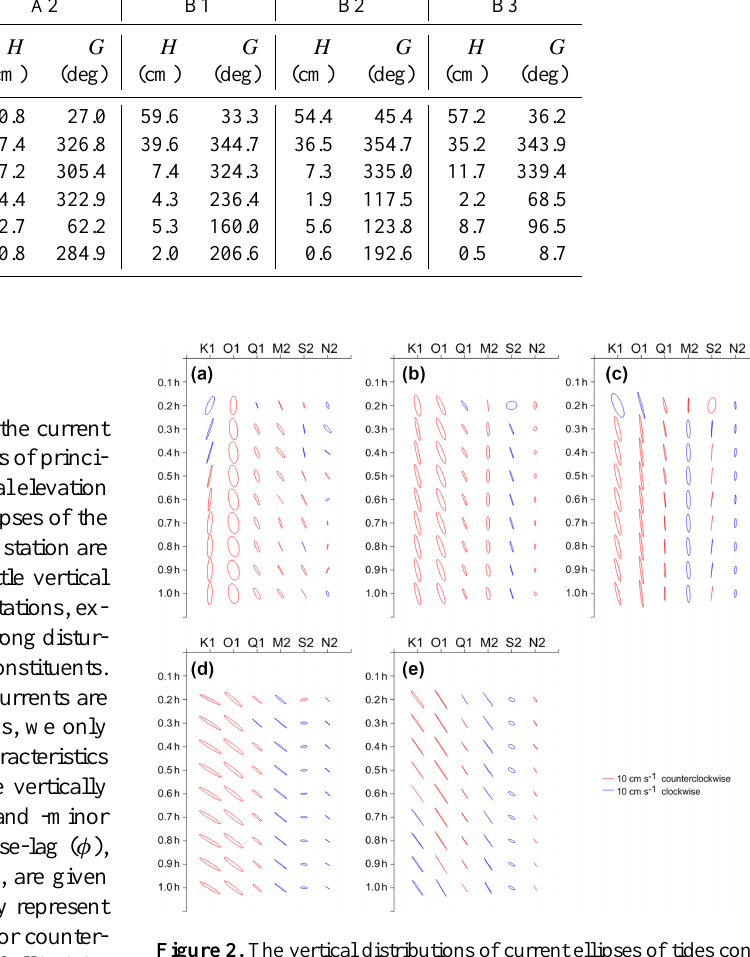
Figure 2. The vertical distributions of current ellipses of tides con- stituents K 1 , O 1 , Q 1 , M 2 , S 2 , and N 2 at Stations A1 (a) , A2 (b) , B1 (c) , B2 (d) , and B3 (e) . rent ellipses of the semidiurnal constituents M 2 and S 2 are generally smaller than 5 cm s − 1 at all